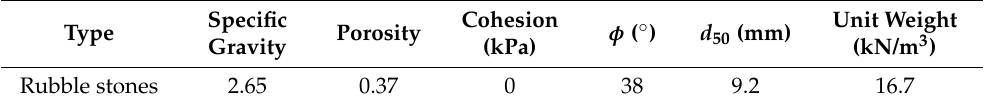
Table 1. Properties of the rubble stones used in the experiments.